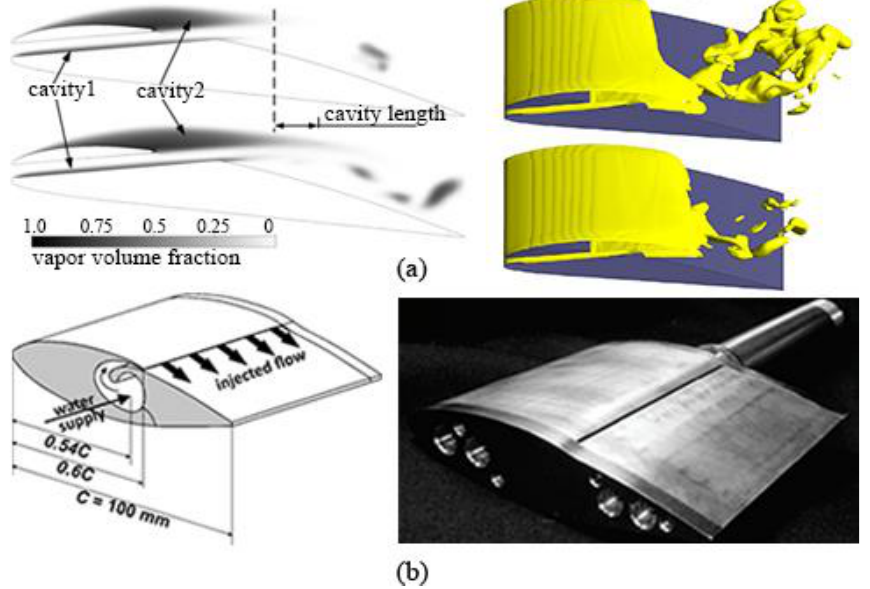
Figure 1. Application of different slotting designs for cavitation suppression. ( a ) Cavitation suppression in hydrofoils; ( b ) cavitation-tolerant hydroturbine guide vane.